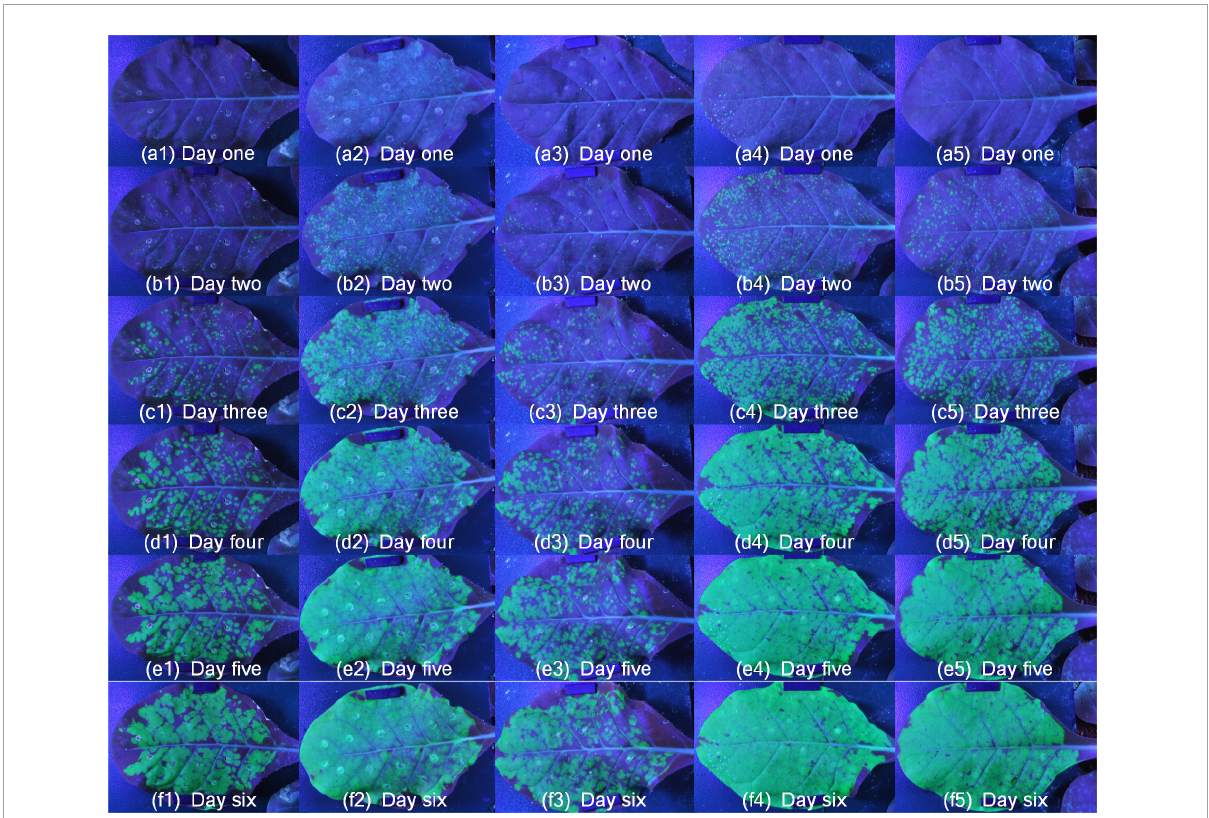
FIGURE6 The change of green fluorescence of SR1 and 4 mutant lines. Numbers 1 to 5 represented mutant-1, SR1, mutant-3, mutant-2 and mutant-4, respectively, and panels (a–f) represented different periods over